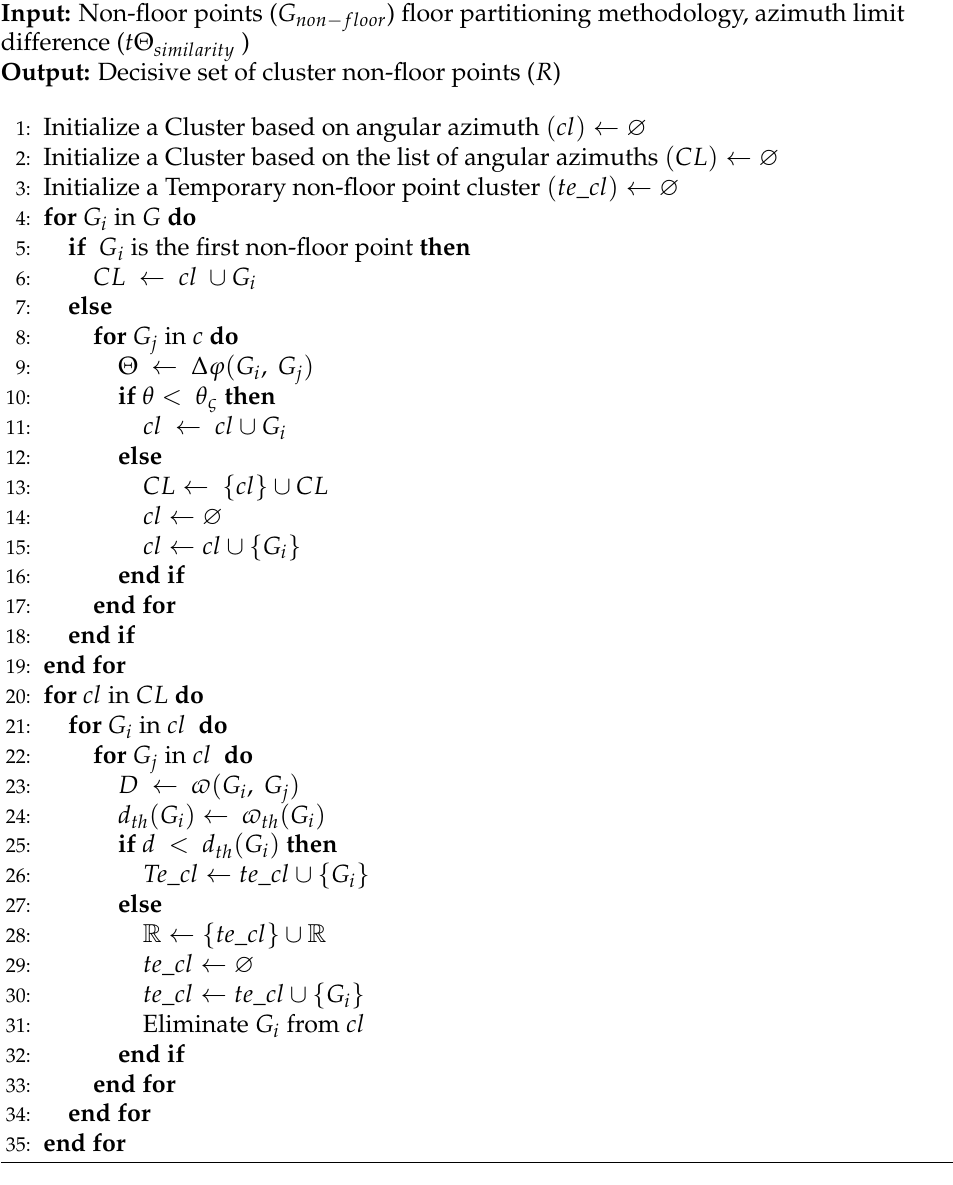
Algorithm 1 Cluster-based non-floor point dismemberment